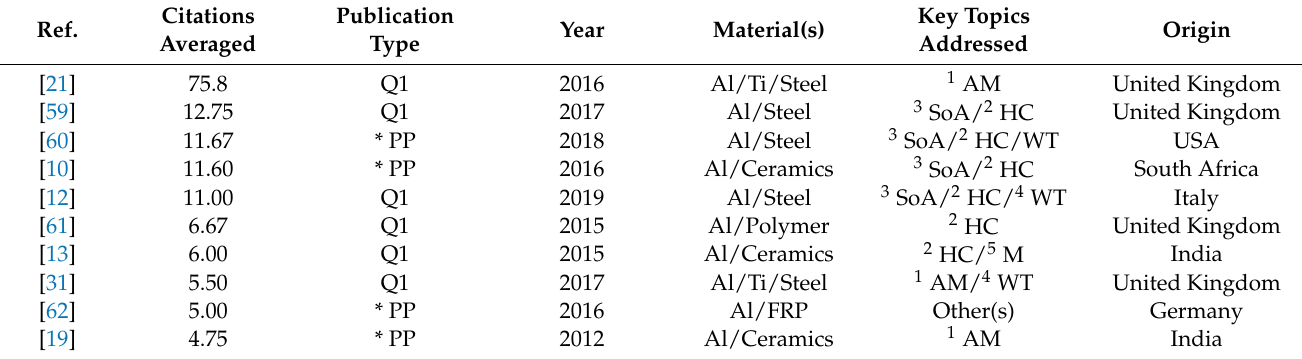
Table 4. Summary of studies including aluminum alloys, listed by the average number of citations per years published.